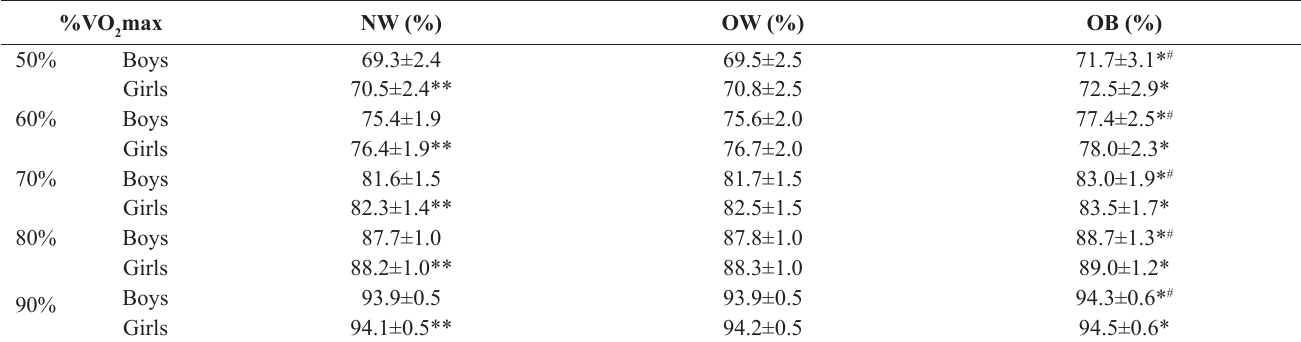
max in normal weight, overweight, and obese 2